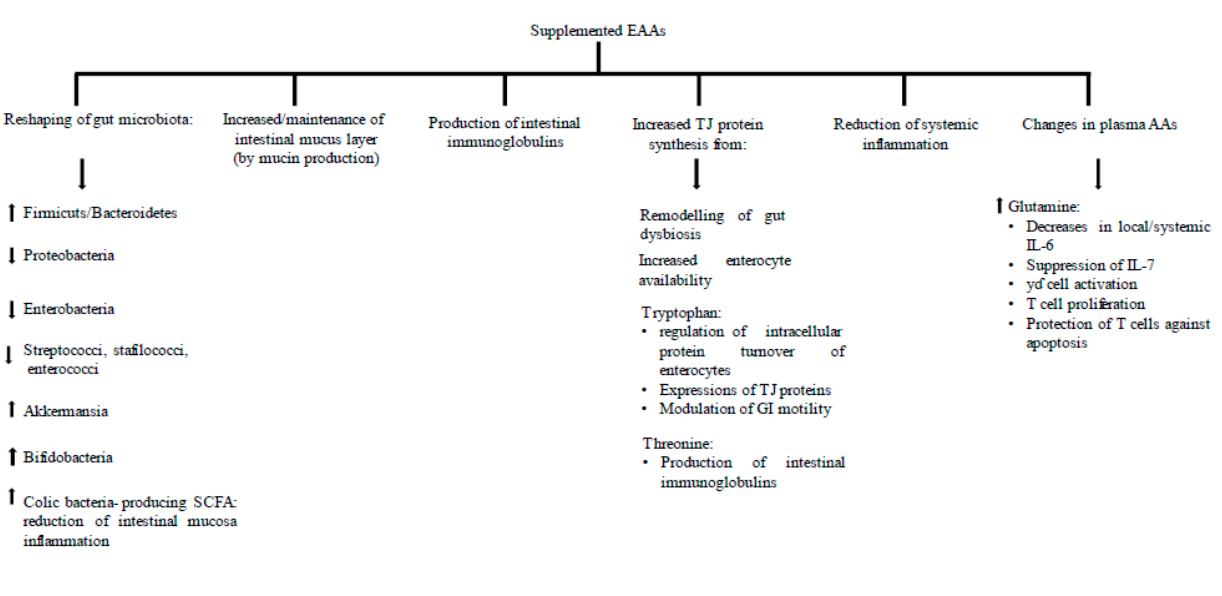
Figure 2. Some potential mechanisms underlying EAA-associated improved intestinal barrier dys- function in the study